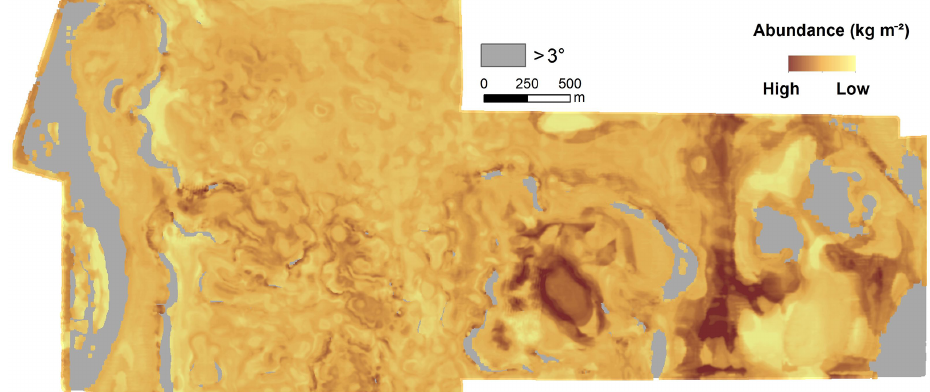
Figure 15. The total abundance of Mn nodules from the surface and embedded in the sediment (max 15cm), in areas with slope ≤ 3 ◦ inside block G77 (continuous values of abundance are not given due to